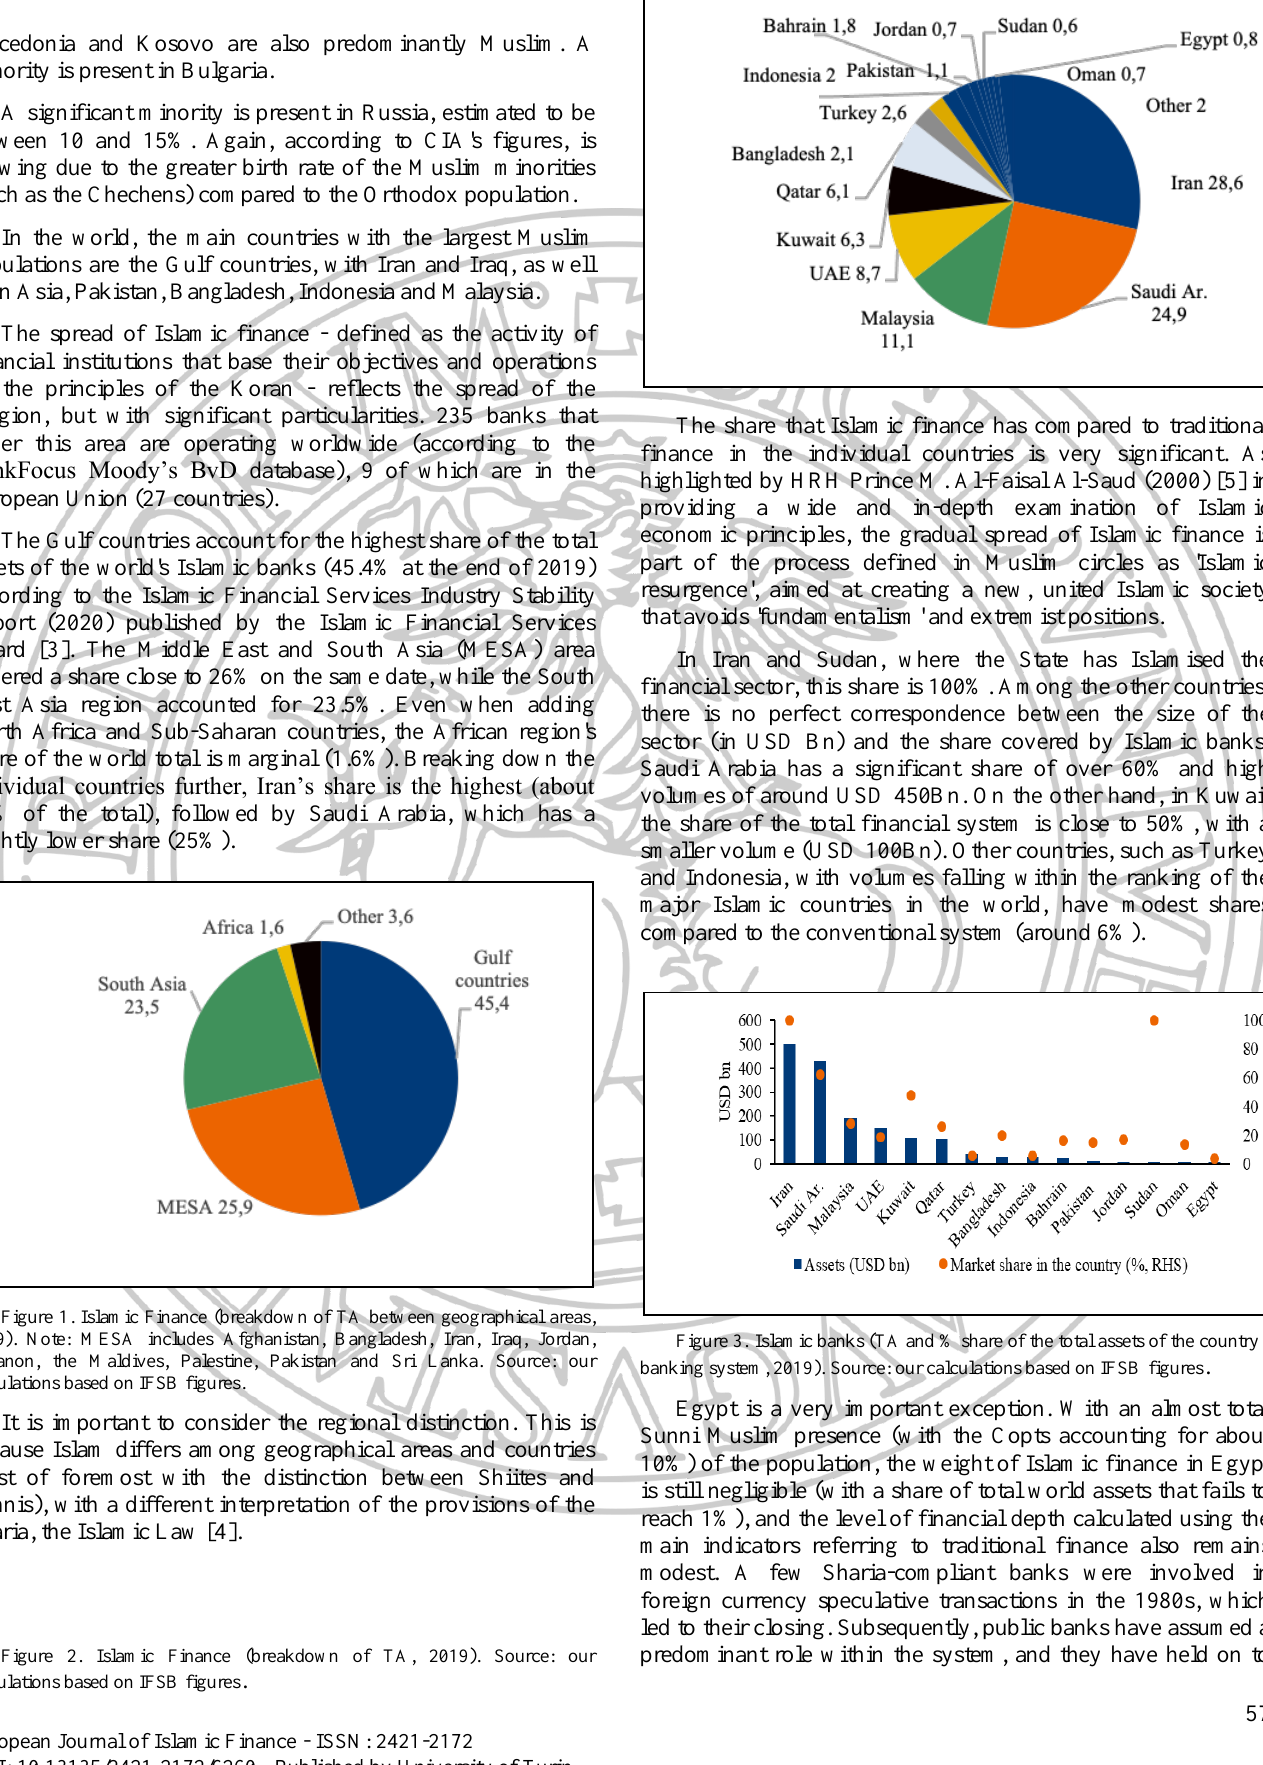
Figure 3. Islamic banks (TA and % share of the total assets of the country's banking system, 2019). Source: our calculations based on IFSB figures